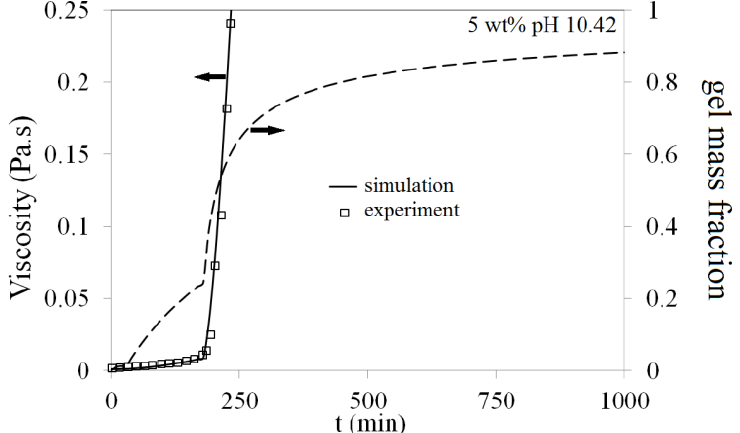
Figure 4. Simulated gel mass fraction and viscosity for 5 wt% sodium silicate (Na-silicate) at pH = 10.42 as a function of time. The simulated viscosity profile is compared with the measured